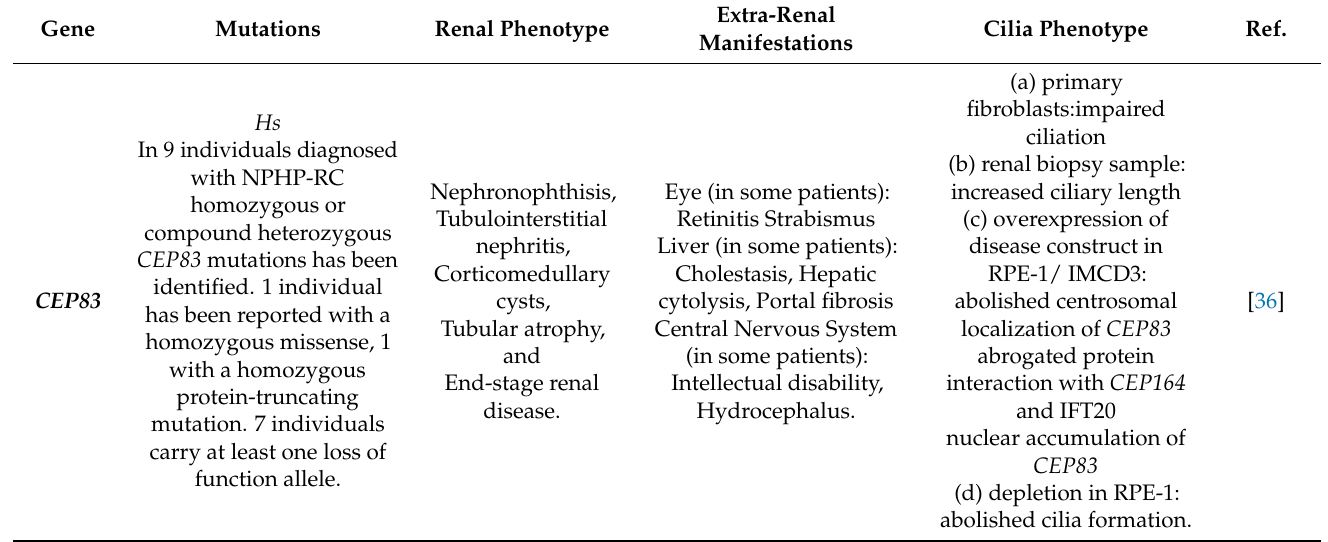
Figure 4. The role of DAPs in ciliogenesis. ( A ). CEP83 recruits E3 ligase and phosphorylates TTBK2 to remove the CP110– CEP97 complex and induce MPP9 degradation. ( B ). CEP164 has three roles: (1) the formation of the CEP164 –Cby complex to recruit TTBK2; (2) the recruitment of EDH1 to enhance PCV formation; and (3) the interaction with Rabin8 to activate Rab8. ( C ). LRRC45 and CEP89 organize centriolar satellites. CEP89 plays a direct role in EDH1 recruitment. ( D ) FBF1 regulates the lateral diffusion of the IFT complex. Image was created by BioRender. Table 1. Summary of the current knowledge of DAP genes in relation to human molecular genetics, including its phenotypic description and available animal